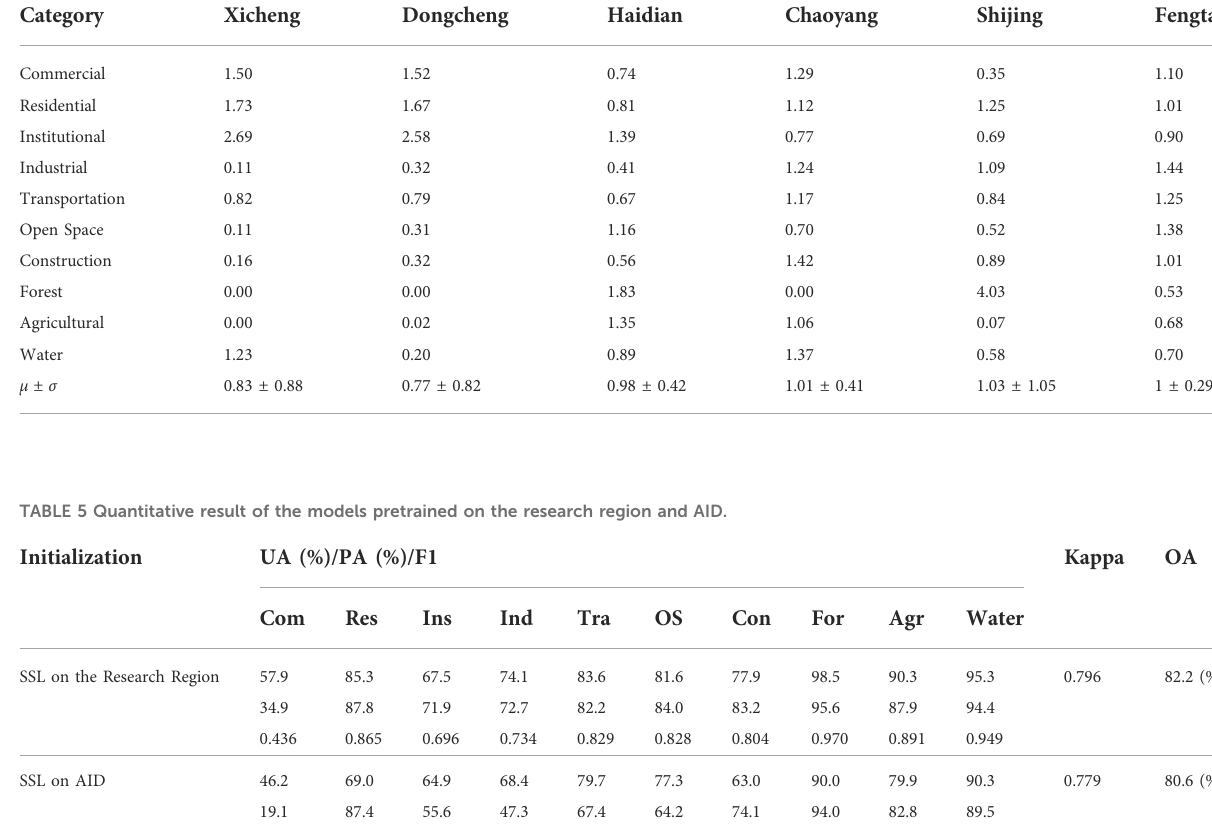
TABLE 4 Location quotient based on administrative district.